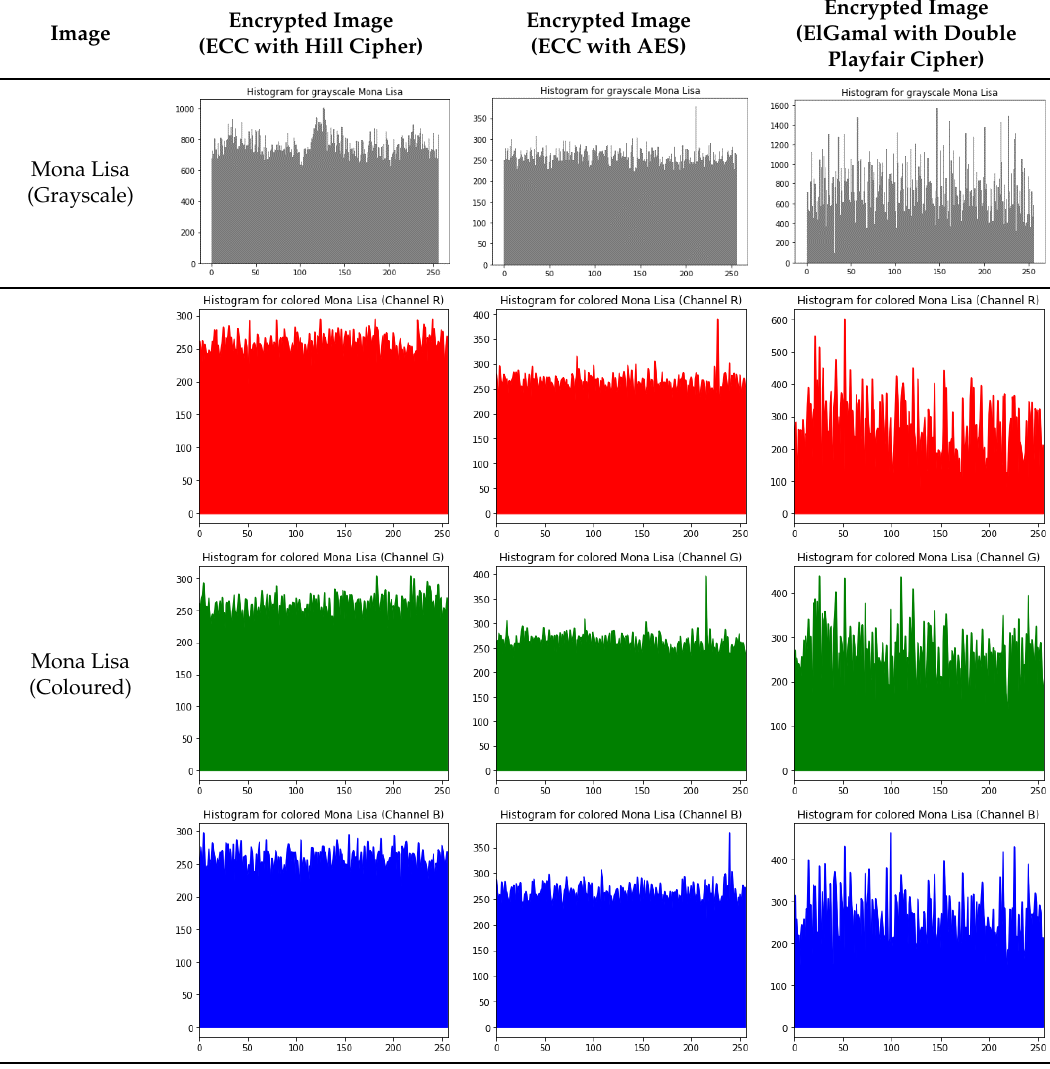
Table 7 shows histogram of red, green and blue component of gray scale and coloured image (Egg). It is clearly visible that histogram of cipher image is fairly uniform and it does not leak any amount of information about the plain